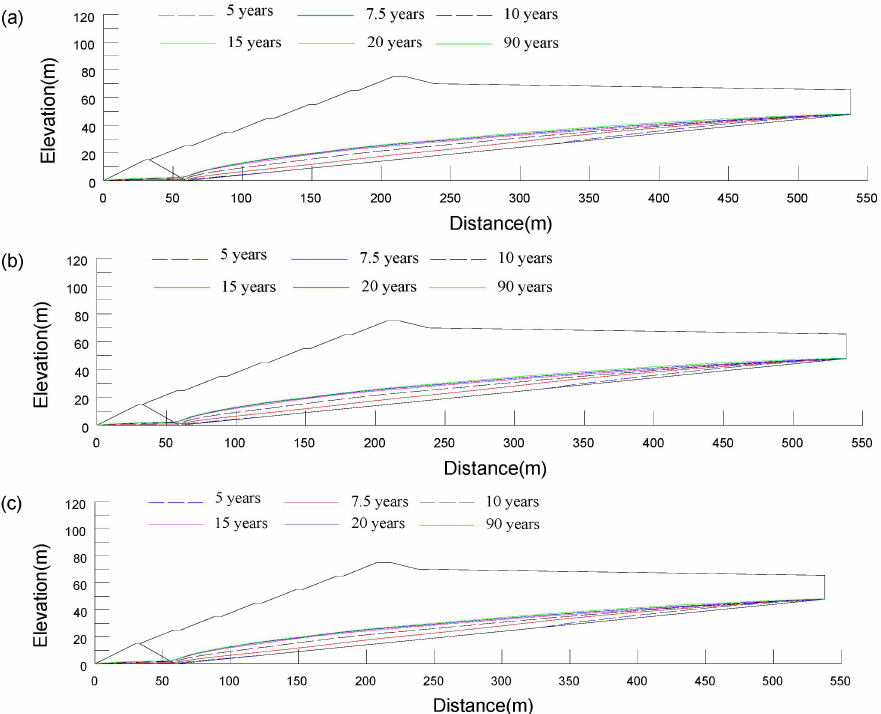
Figure 6. The spatial–temporal evolution law of the saturation line in the tailings pond (Taiyuan, 400 mm): ( a ) Taiyuan 2018 (caseII-a); ( b ) Taiyuan 2019 (caseII-b); ( c ) Taiyuan 2020 (caseII-c).